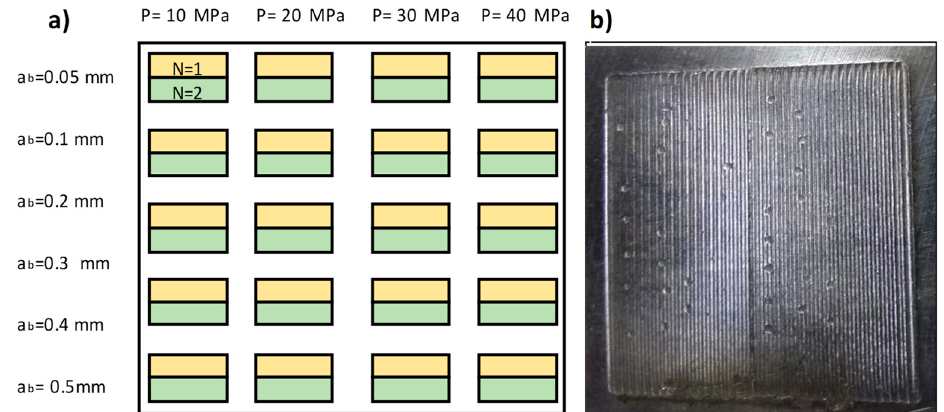
Figure 4. Different burnishing tests in the base material. ( a ) Test design. ( b ) Real performed burnishing tests according to test design.